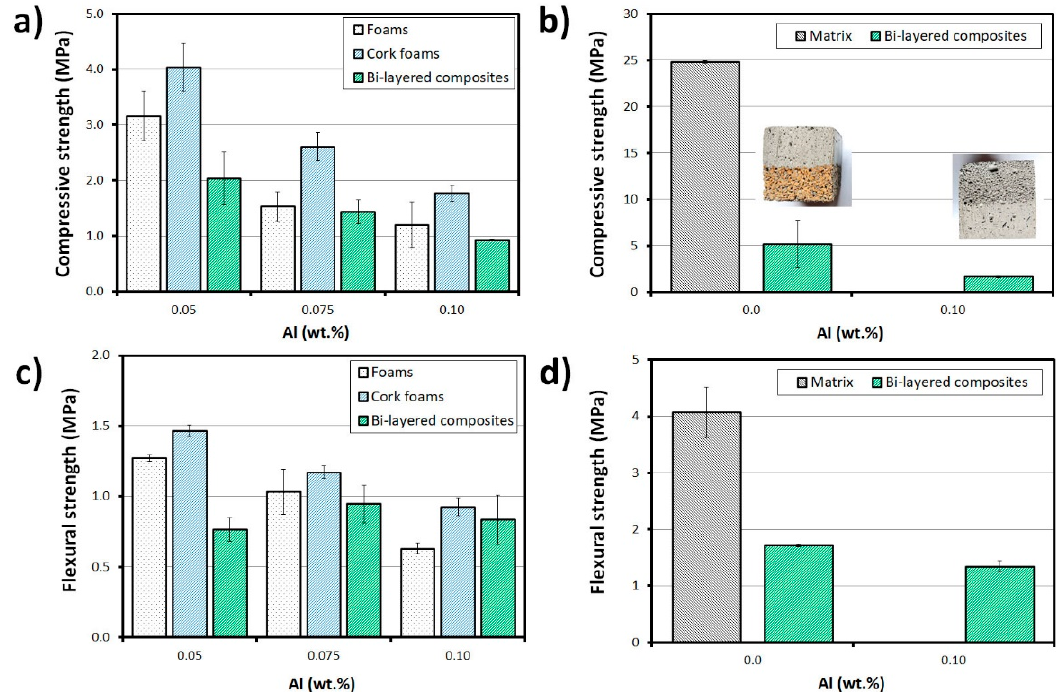
Figure 8. Compressive ( a , b ) and flexural ( c , d ) strength of the various inorganic polymers (measured at the 28th day).